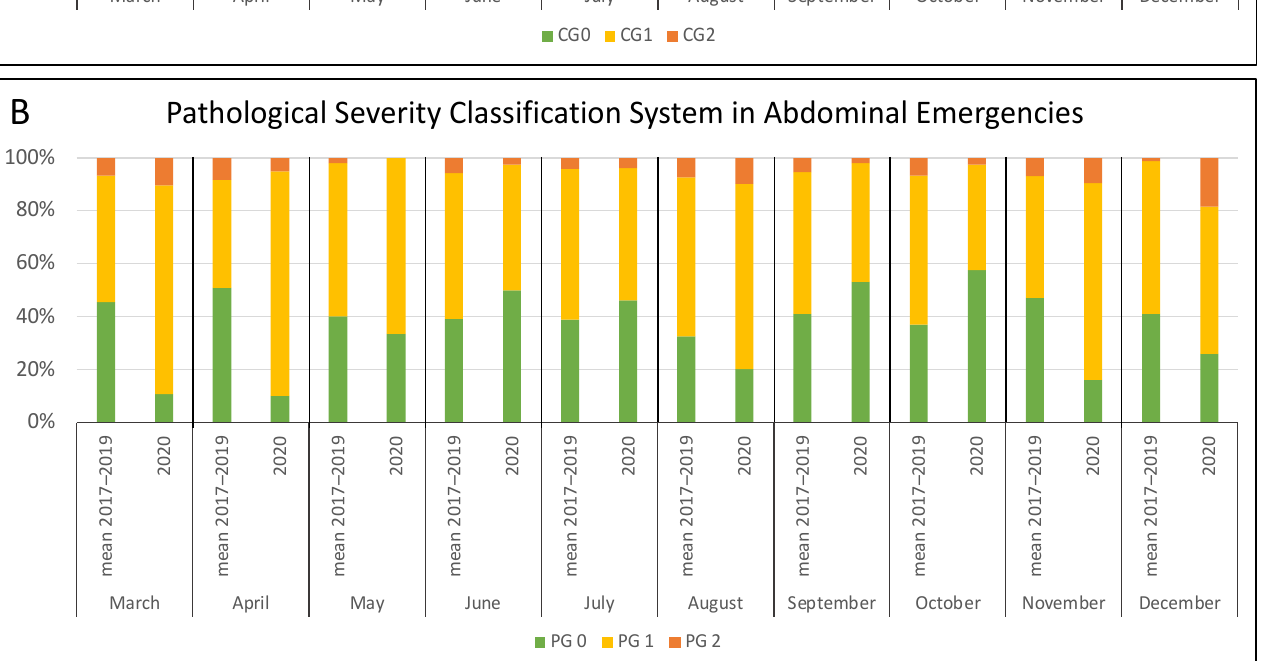
Figure 2. Monthly distribution of patients undergoing surgery for abdominal emergencies according to the clinical ( A ) and pathological ( B ) severity classification system: comparison between the 2017–2019 period and 2020.